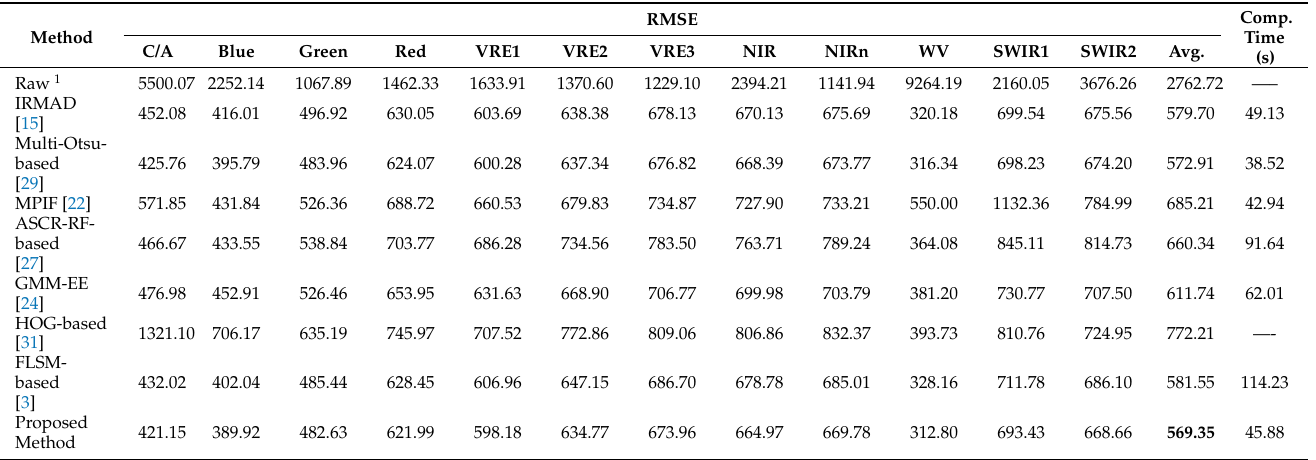
Table 5. Comparison between the accuracy and componential time of different SRRN methods and the proposed method for dataset 3.